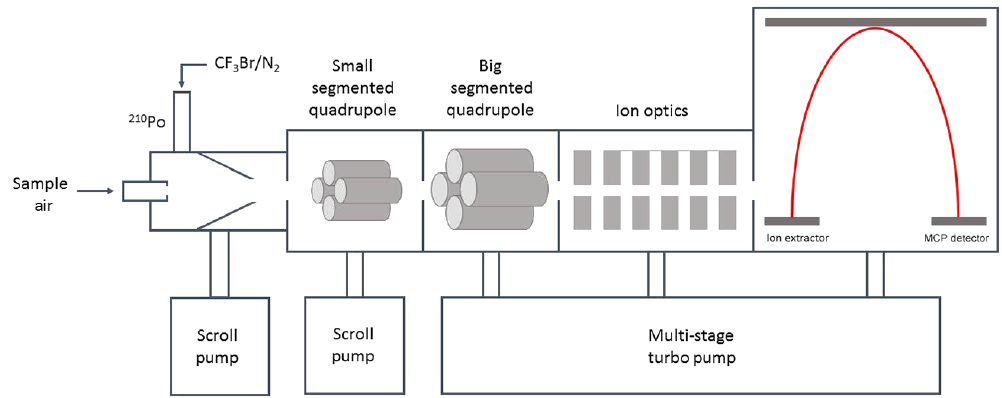
Figure 1. Schematic diagram of the high-resolution time-of-flight chemical ionization mass spectrometer (HR-ToF-CIMS). Sample air enters the ion–molecule reaction region through a 0.5mm orifice where it is ionized at 100mbar. The contents of the ion–molecule reaction region are sub-sampled through a 0.3mm orifice into the small segmented quadrupole (SSQ) chamber held at 2.5mbar. Collisional dissociation occurs in the SSQ. Ion products are then collimated by the big segmented quadrupole (BSQ) where they also dissipate energy by collisions with background gas at reduced pressure. The subsequent ion lenses then focus and accelerate the ion beam towards the ToF